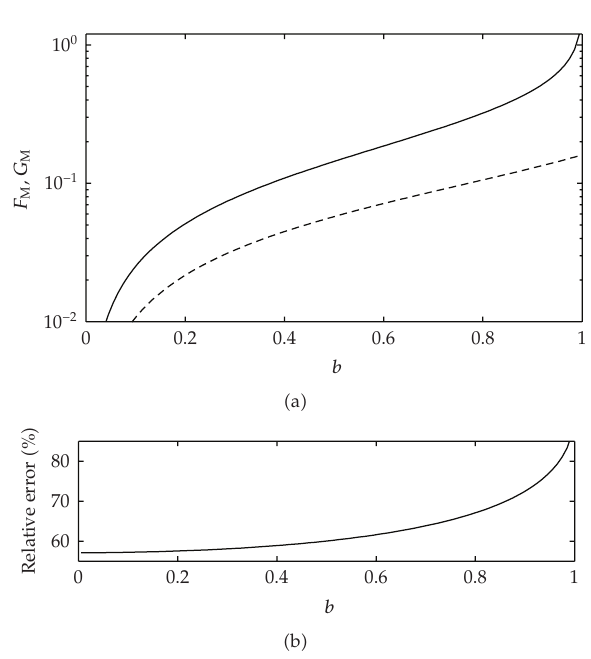
Figure 6: The series F M from (cid:2) 3.17 (cid:3) (cid:2) solid line (cid:3) compared to the integral representation G M from (cid:2) 3.18 (cid:3) , as given in Marshall (cid:4) 21 (cid:5) (cid:2) dashed line (cid:3) . In the lower panel, the relative error with respect to the direct summation of the series is